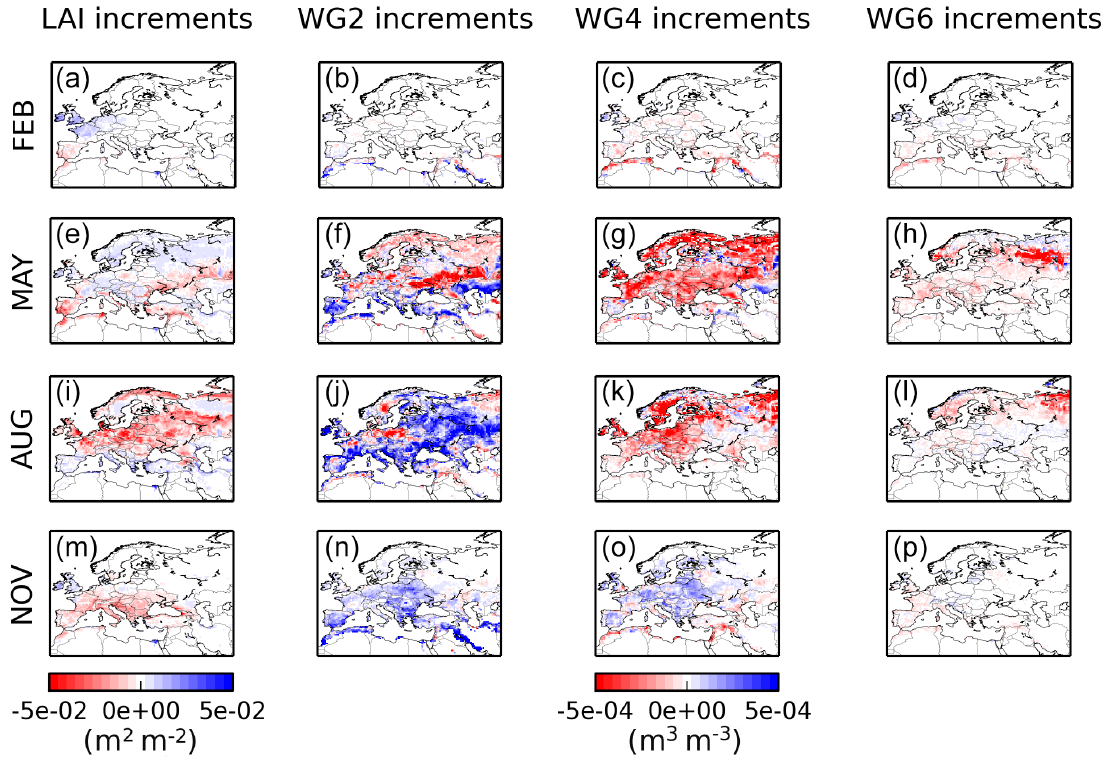
Figure 5. Rows from top to bottom represent averaged analysis increments for all months of February, May, August and November over 2000–2012. From left to right, four control variables are illustrated: leaf area index and soil moisture in the second ( w 2 , 1–4cm), fourth ( w 4 , 10–20cm) and sixth ( w 6 , 40–60cm) layer of soil, respectively.